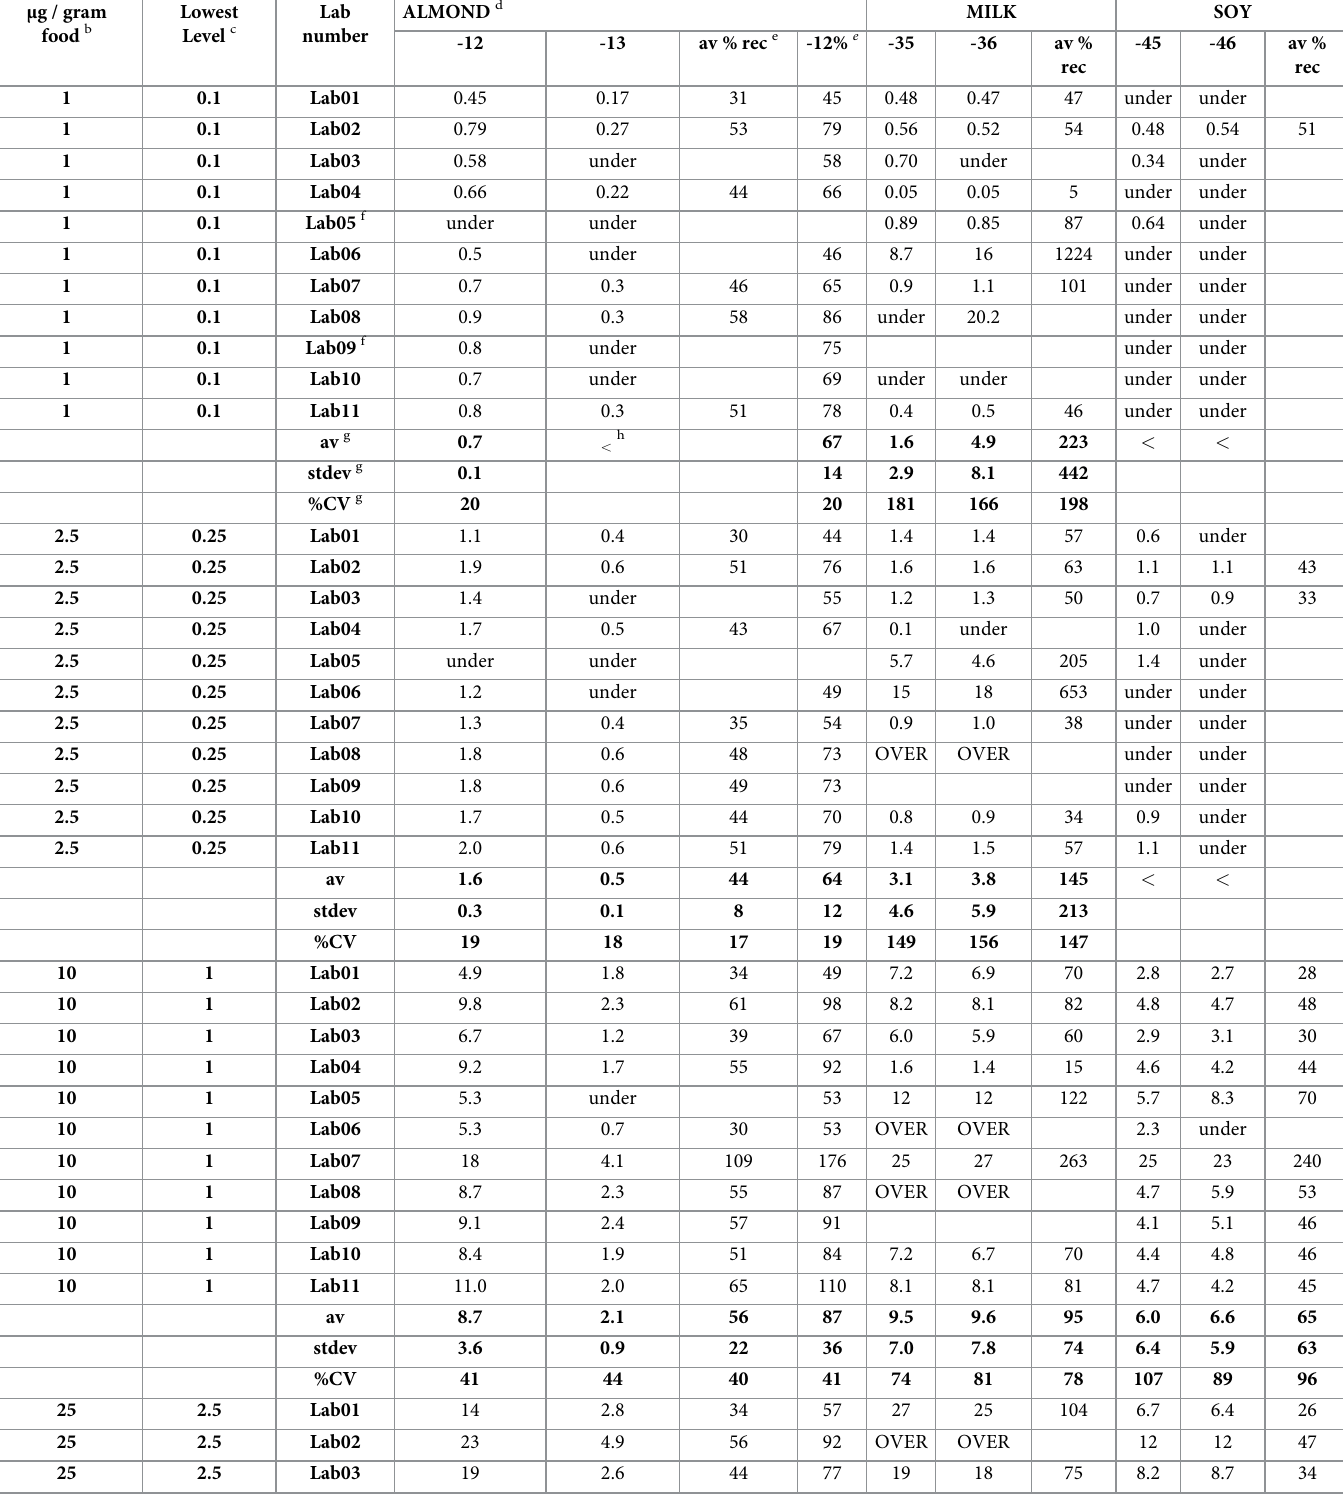
Table 13. Interpolated analyte recovered from incurred food samples: Orange juice and dark chocolate a . μ g / gram food